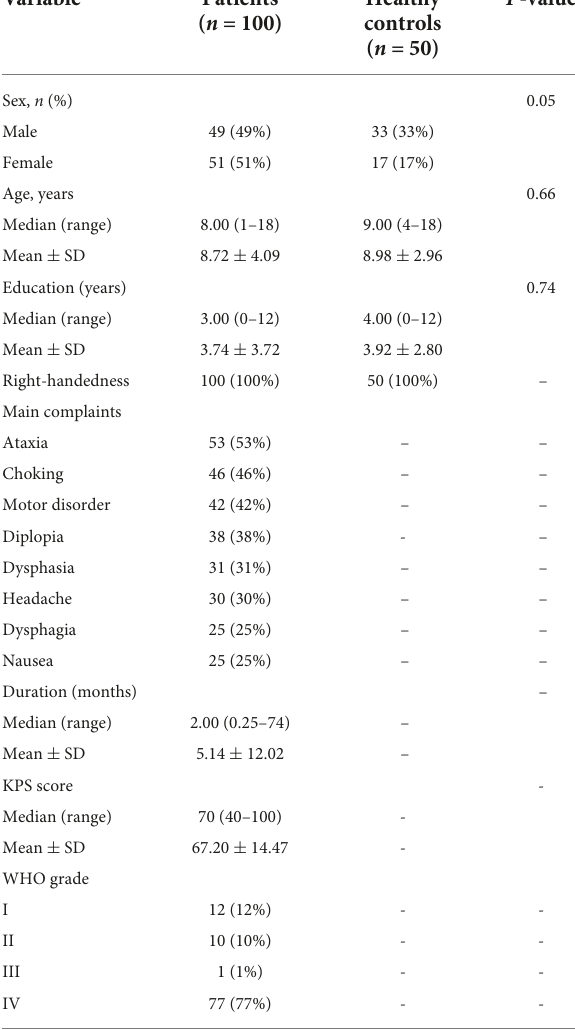
TABLE 1 Demographic and clinical characteristics of patients and healthy